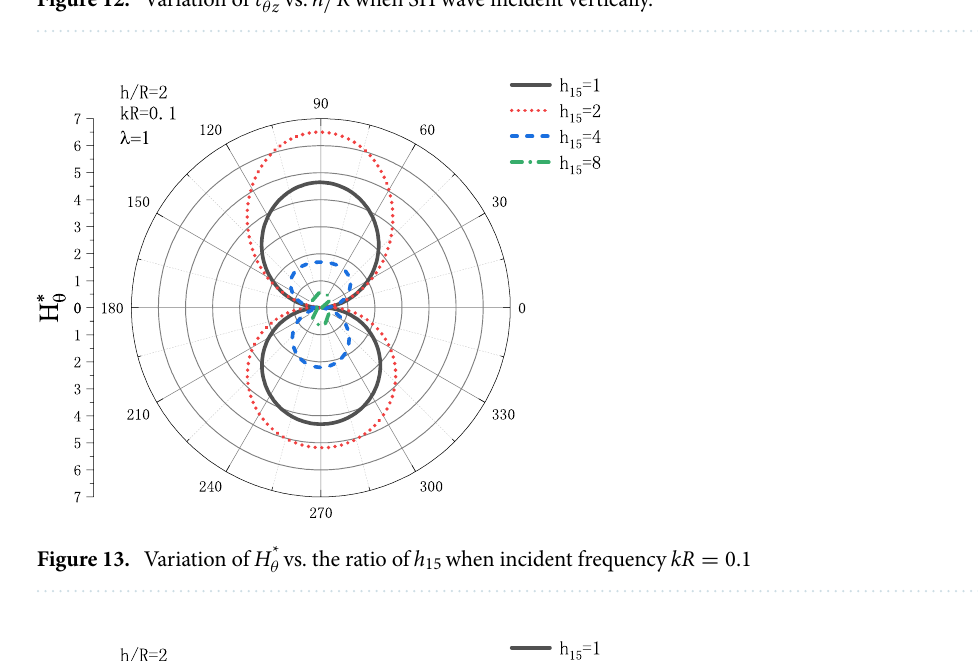
Figure 12. Variation of τ ∗ θ z vs. h